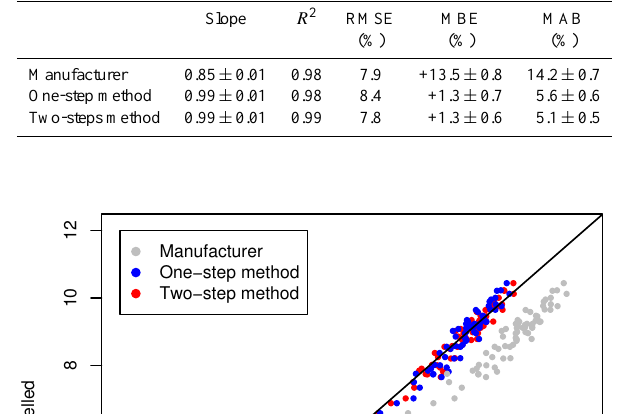
Table 1. Parameters obtained in the correlation between mea- sured and modeled UVI data. Experimental measurements are de- rived from manufacturer factor, and one-step and two-steps meth- ods, while modeled data are inferred from LibRadtran/UVSPEC code. The parameters are as follows: the slope of the regres- sion, the coefficients of correlation ( R 2 ), the root mean square er- rors (RMSE), the mean bias error (MBE), and the mean absolute bias error (MABE). The relative differences are calculated as mea- sured minus modeled, divided by the modeled UVI data.